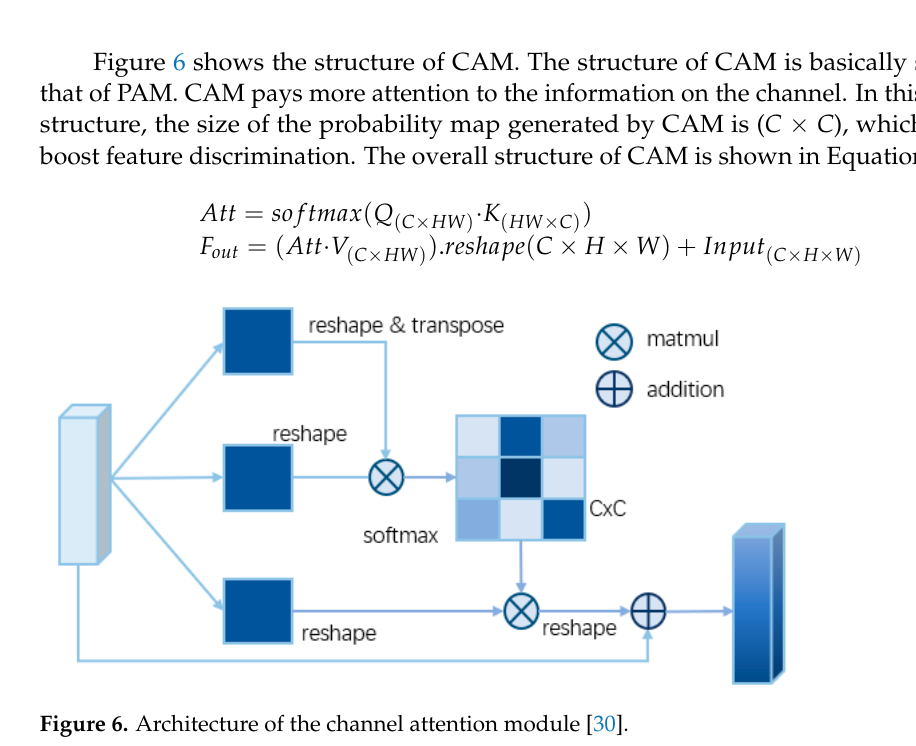
Figure 6. Architecture of the channel attention module [30].